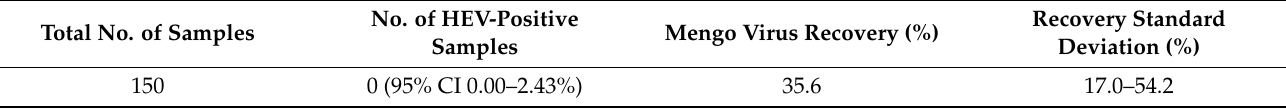
Table 5. Summary of HEV detection in blueberries harvested in